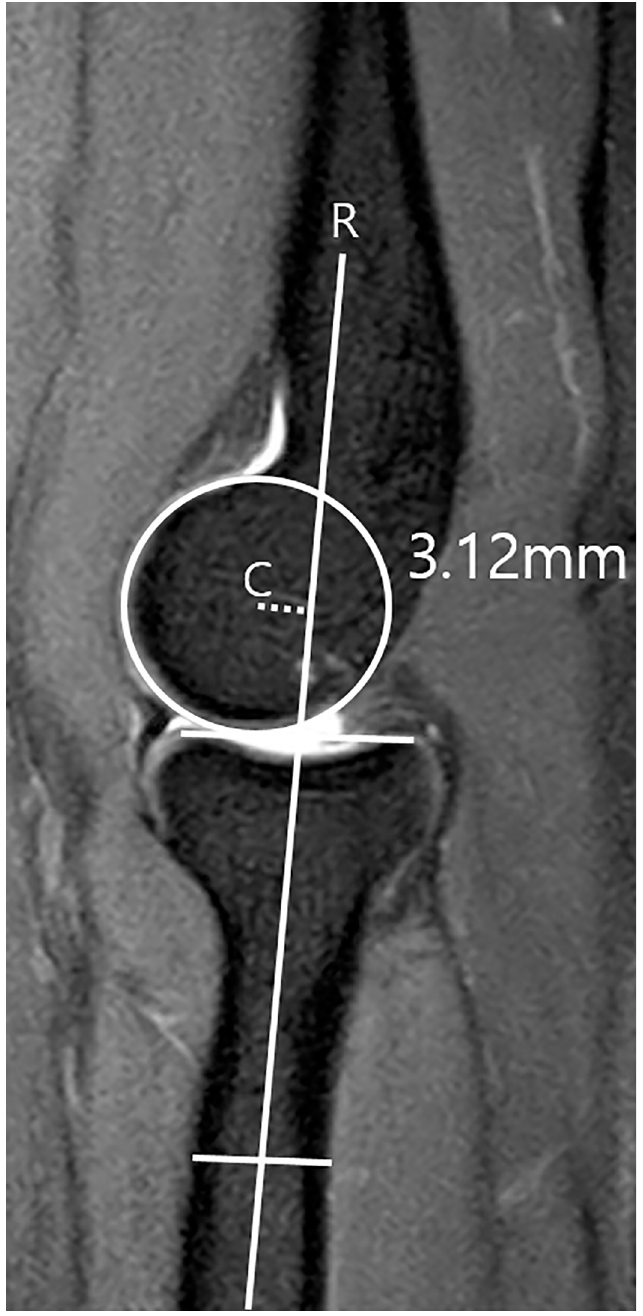
Fig 2. Measurement of radiocapitellar incongruity of the radial head. In sagittal image through the center of the radial head, the center of the capitellum (C) and the longitudinal axis of the proximal radius (R) were marked. The minimum distance between (C) and (R) was